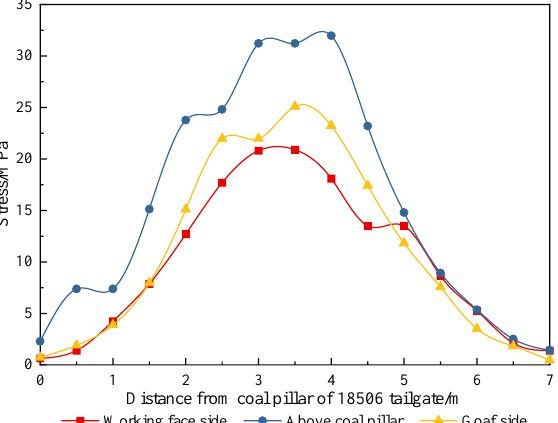
Figure 10. Vertical stress curve of surrounding rock at different top cutting positions.